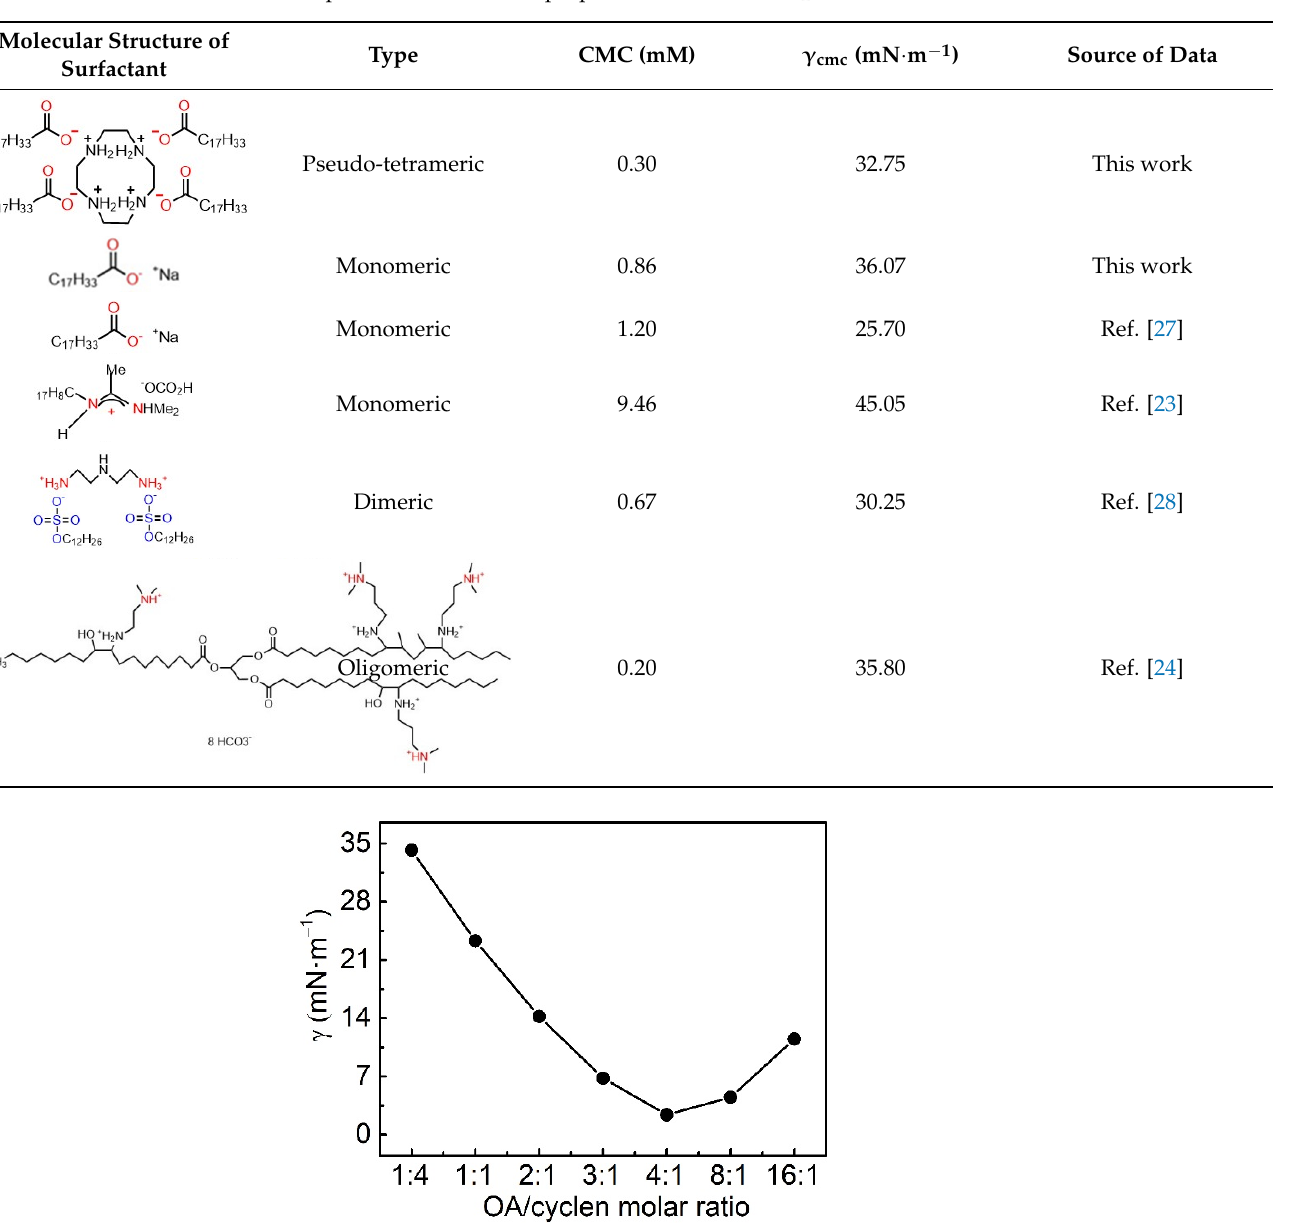
Figure 3. The variation in the interfacial tension with different molar ratios of OA and cyclen at 25 °C; the total concentration of OA/cyclen was fixed at 3.0 wt%.